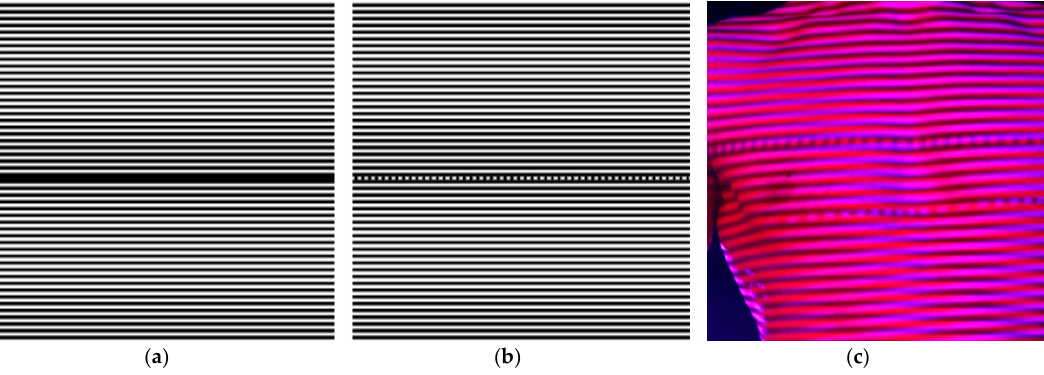
Figure 4. Projected patterns: ( a ) original Sitnik pattern from [43]; ( b ) modified pattern presented in this paper; and ( c ) two spectrally separated patterns (red and blue) projected onto a human body surface.